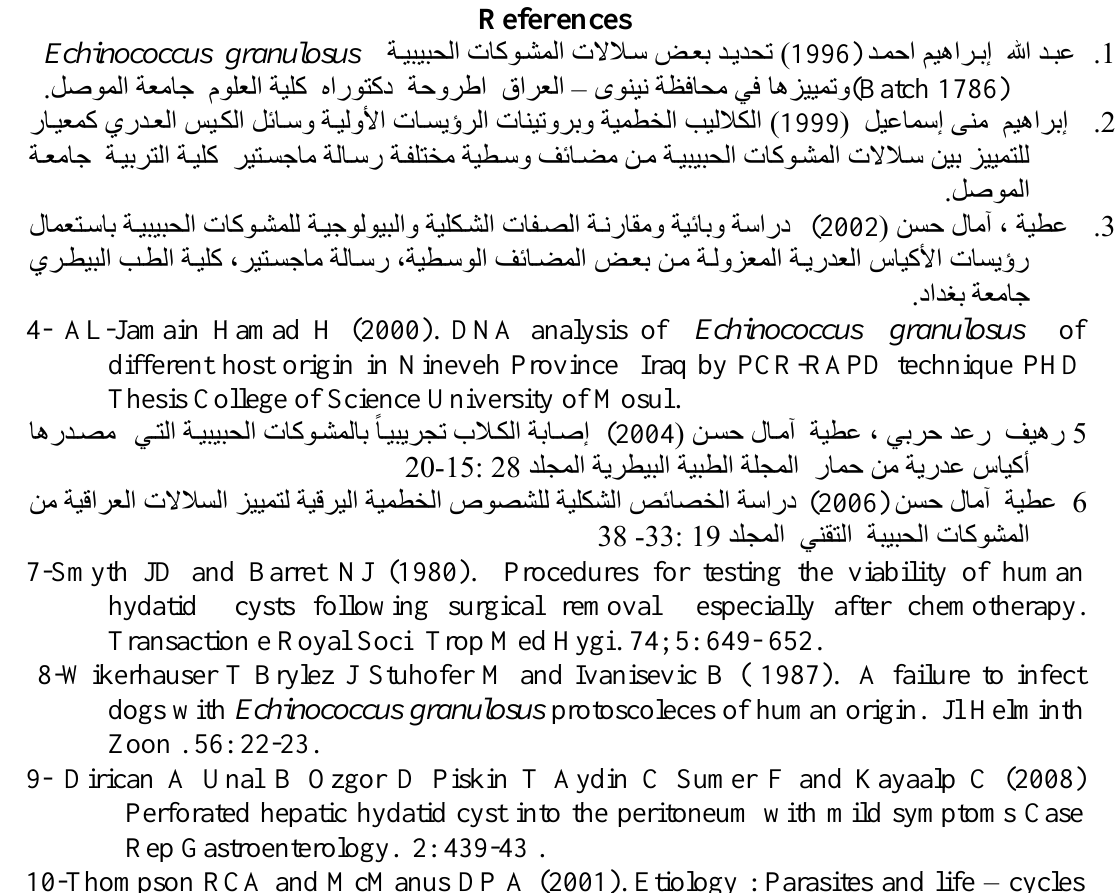
Thesis College of Science University of